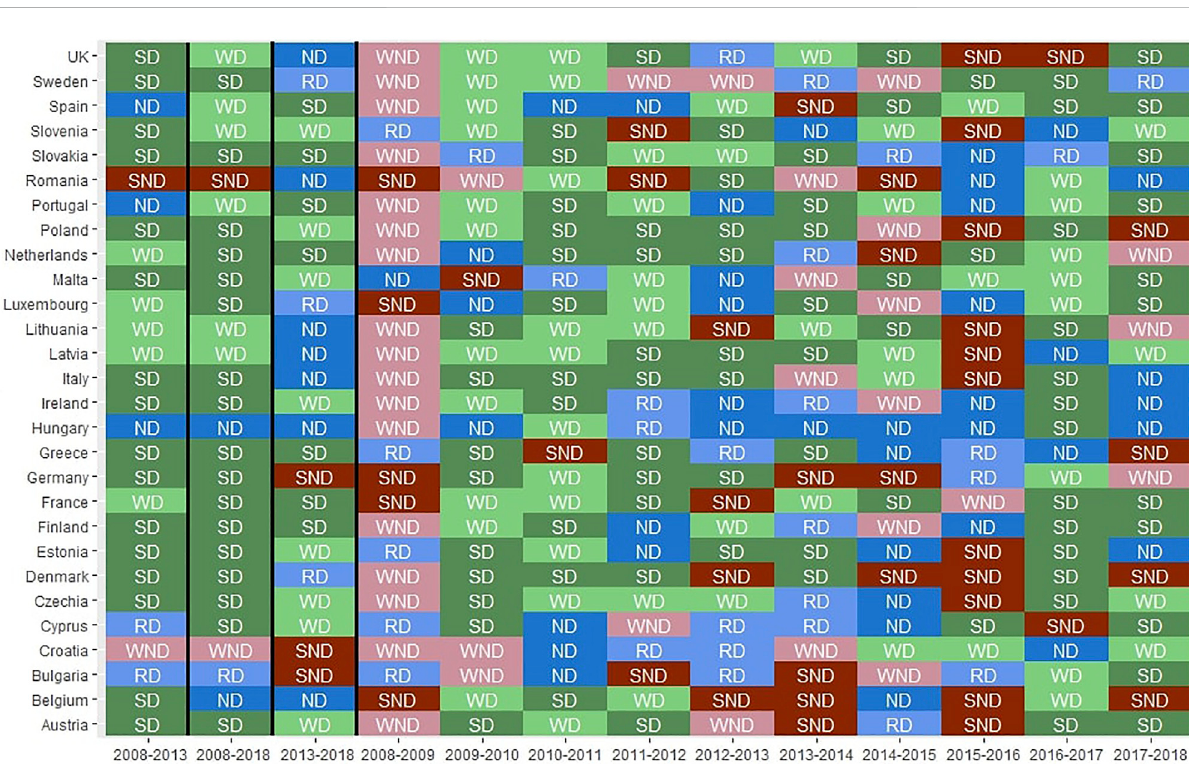
FIGURE 2 CO 2 emissions decoupling. Source: authors ’ calculation based on EEA,